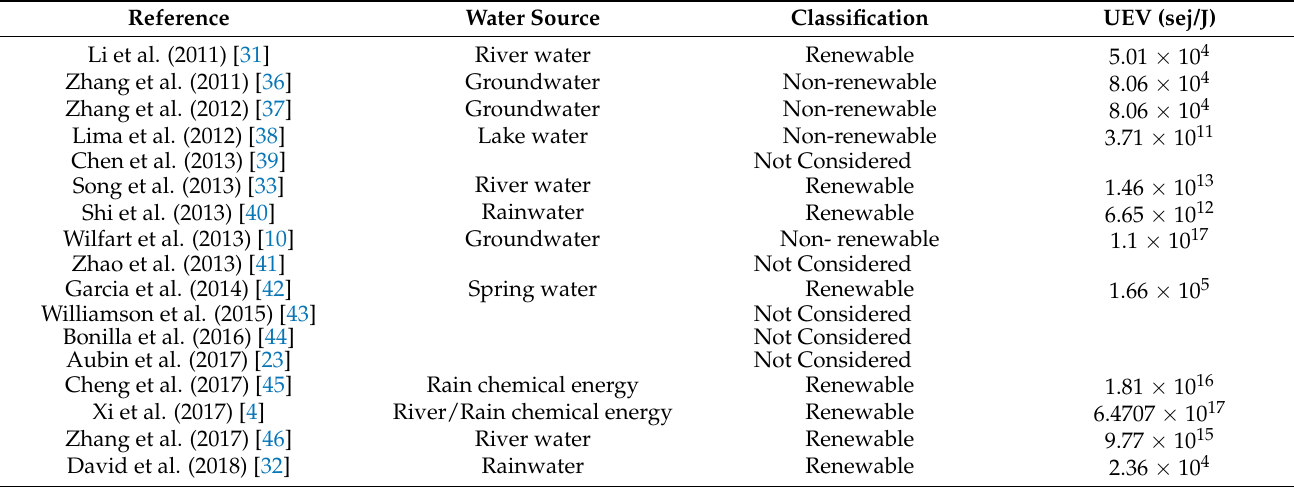
Table 4. Water classification and unit emergy values (UEVs) considered in emergy studies applied to aquaculture